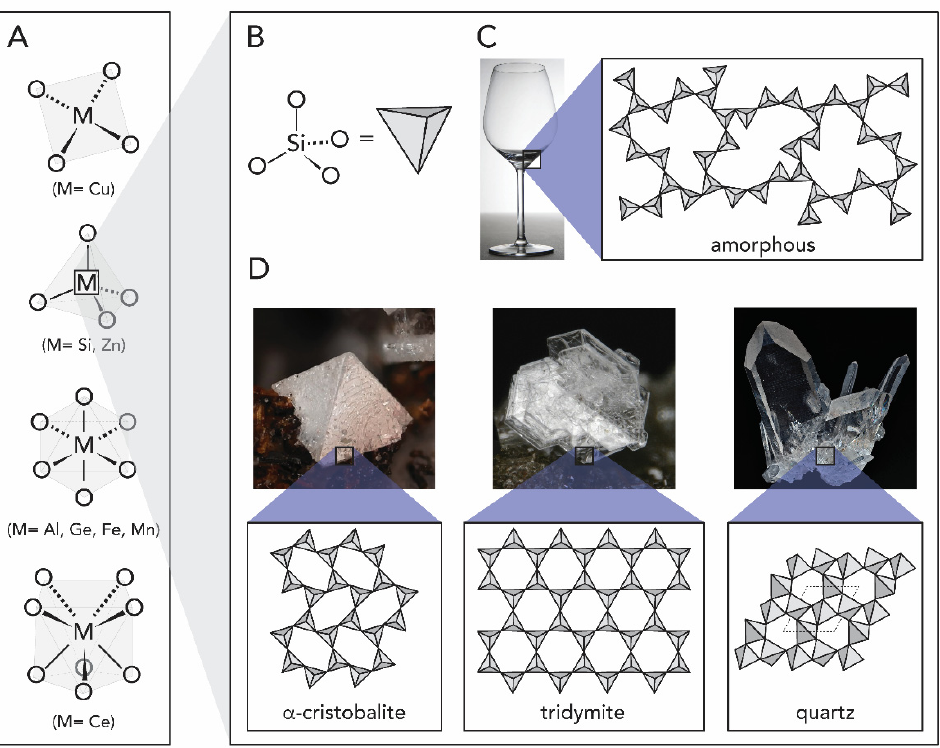
Figure 1. Different arrangements of metal oxides, featured silica and its forms. ( A ) Examples of coordination geometries that M x O y can assume, from top to bottom: quadratic planar, tetrahedral, octahedral and square antiprismatic. ( B ) SiO 4 tetrahedra in silica (SiO 2 ). ( C ) Amorphous SiO 2 . ( D ) Examples of different polymorphs of crystalline SiO 2 : cristobalite, tridymite and quartz. Note that further crystalline polymorphs exist. Photographs of minerals are reproduced from www.mindat.org.